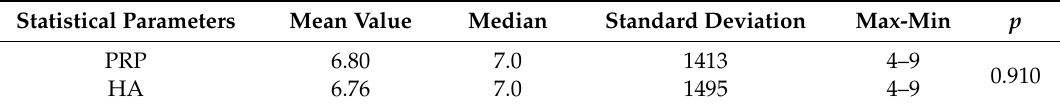
Table 2. Statistical parameters of the mean points of the temporomandibular joint’s pain before management. Statistical